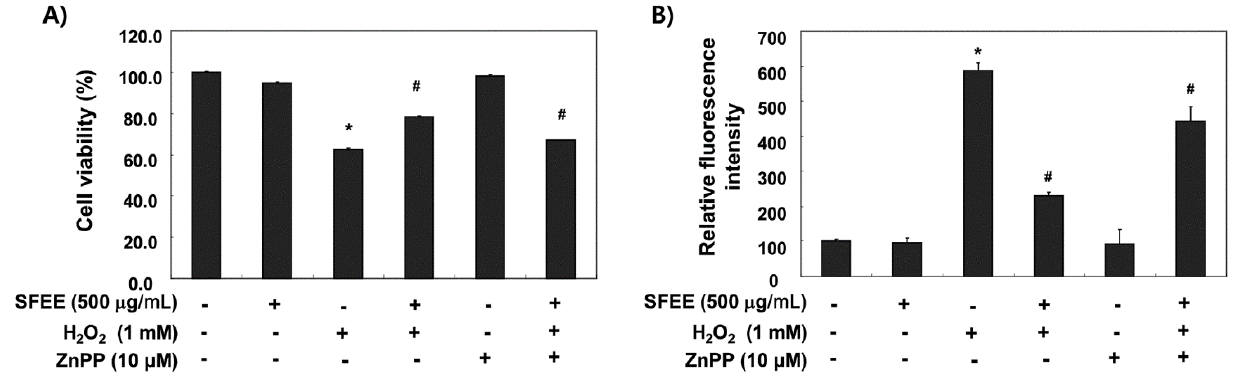
Figure 5. Effects of an HO-1 inhibitor on Schisandrae Fructus ethanol